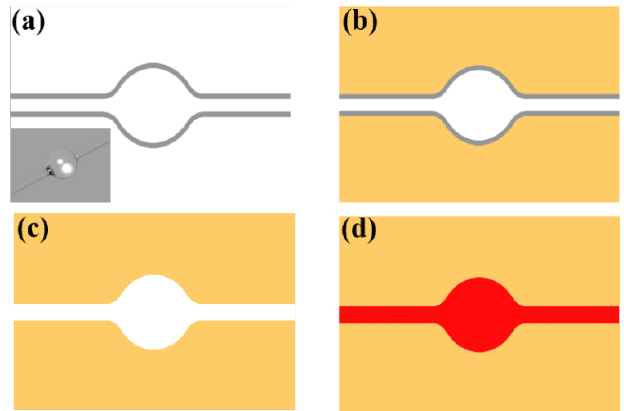
Figure 9. Schematic of the etching process: ( a ) A microbubble was fabricated by fuse-and-blow method. ( b ) The microbubble was packaged by MY133. ( c ) Etching the wall of the microbubble by HF. ( d ) The pure liquid cavity was packaged by MY133 and filled with DMSO (R6G).